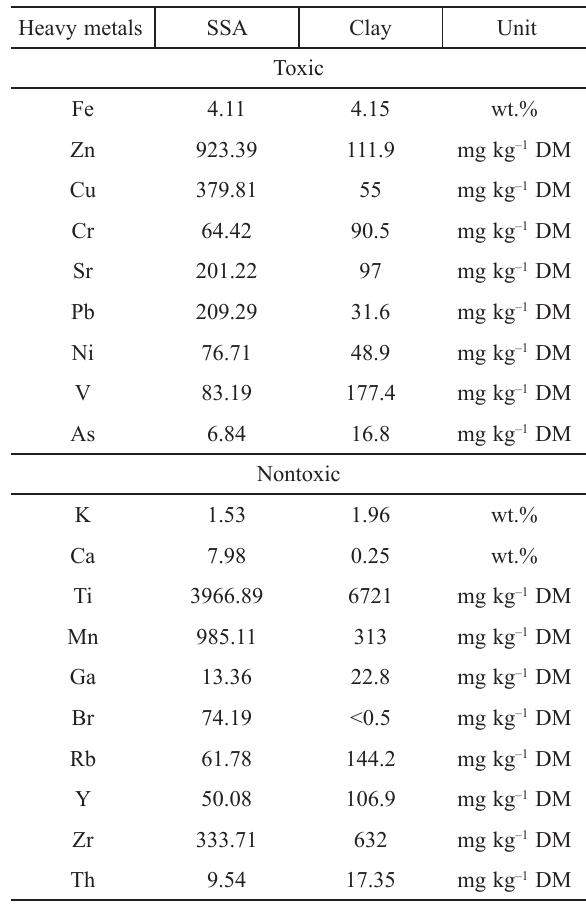
Table 6 – Chemical composition of SSA and clay (heavy